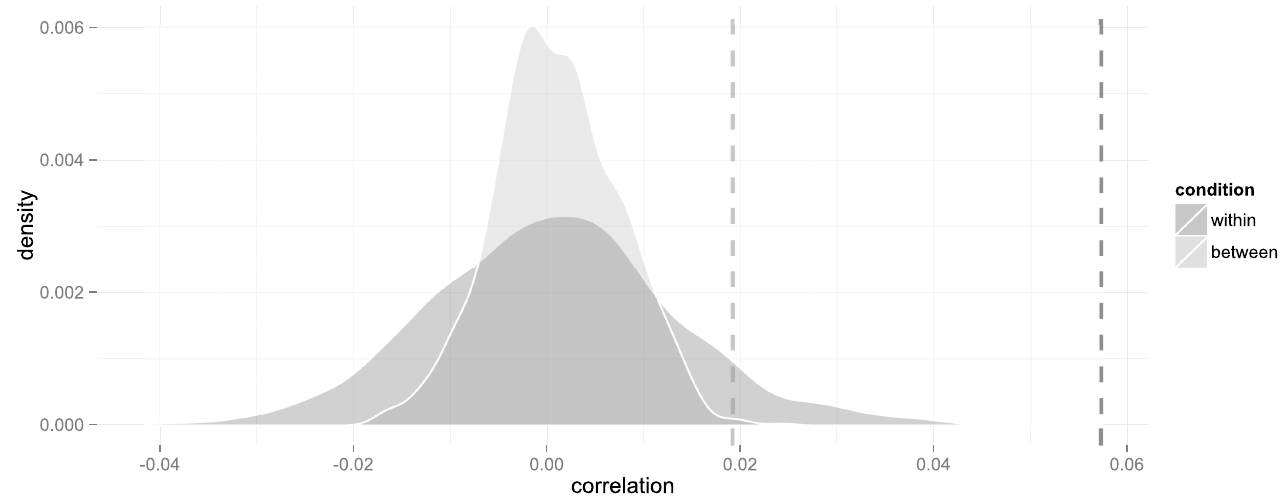
Fig 1. Probability distributions of correlations in the within- and between-group designs under the null hypothesis that choices are randomly allocated irrespective of country of origin. The dashed lines represent the observed correlations.